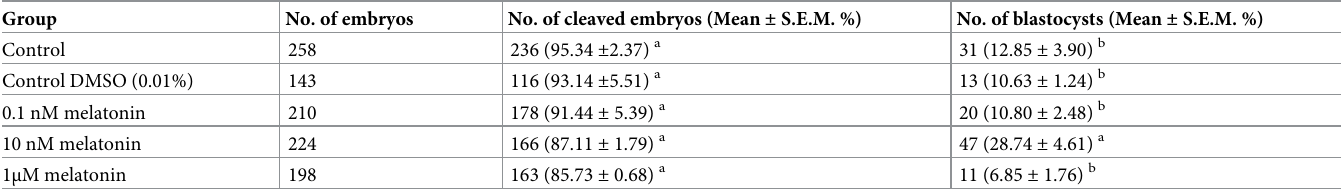
Table 3. Evaluation of various concentrations of melatonin on developmental competence of ovine SCNT embryos. Group